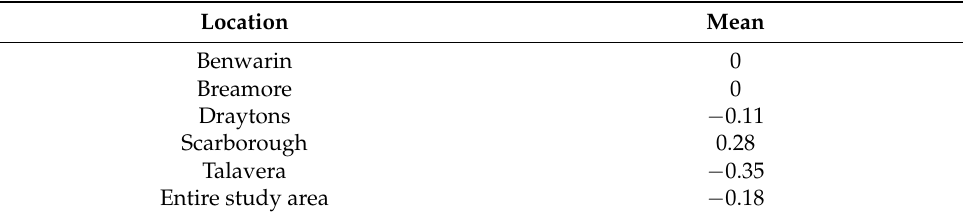
Table 3. Soil redistribution rates (t ha − 1 yr − 1 ) for five vineyards and the entire study area. Location Mean